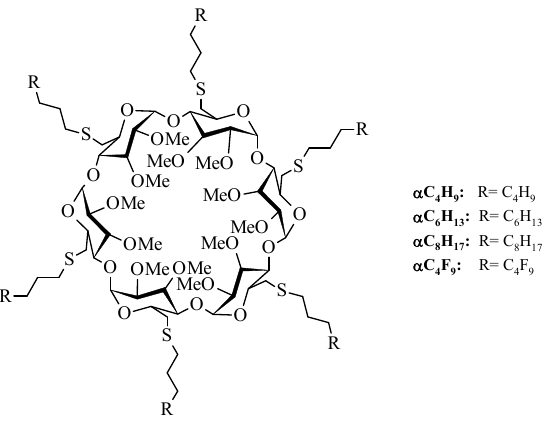
Figure 2. Fluorinated and hydrocarbonated amphiphilic α‐ cyclodextrins used in this study.